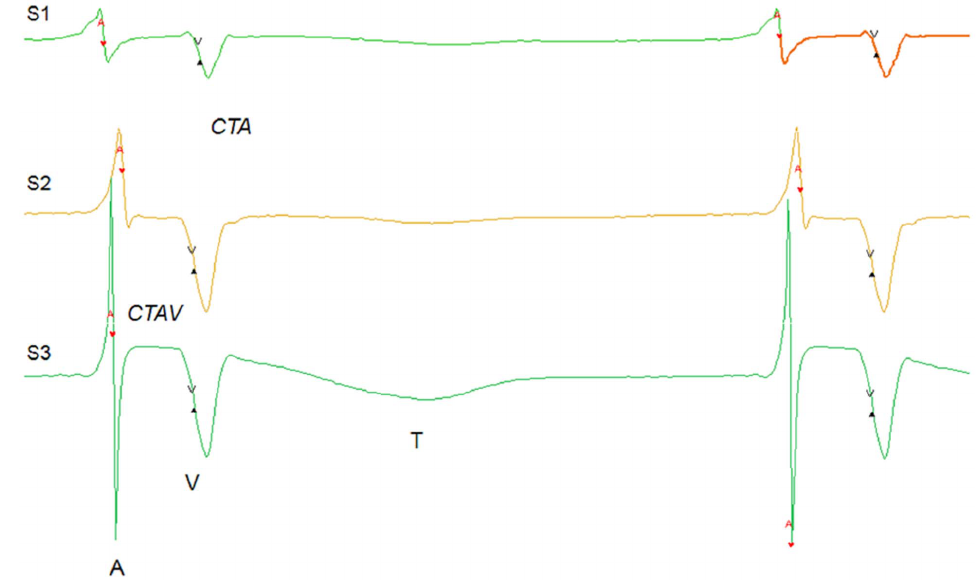
Figure 1. An example of recorded atrial electrogram (AEG): three channels (S1: superolateral right atrium. S2: inferior right atrium; S3: superior left atrium.) AEG in 2 consecutive normal sinus beats. The atrial (A) and ventricular (V) activations are indicated, as well as the ventricular T wave (T). AA , CTA and CTAV are also indicated.